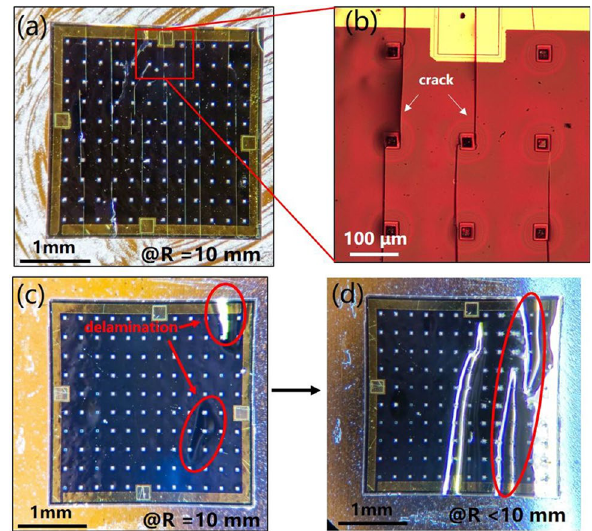
Figure 7. Microscope image of bending flexible InGaAs detector: ( a ) Bending up of R = 10 mm. ( b ) A magnified view of the outline area on the left shows the cracking failure surface. ( c ) Bending down of R = 10